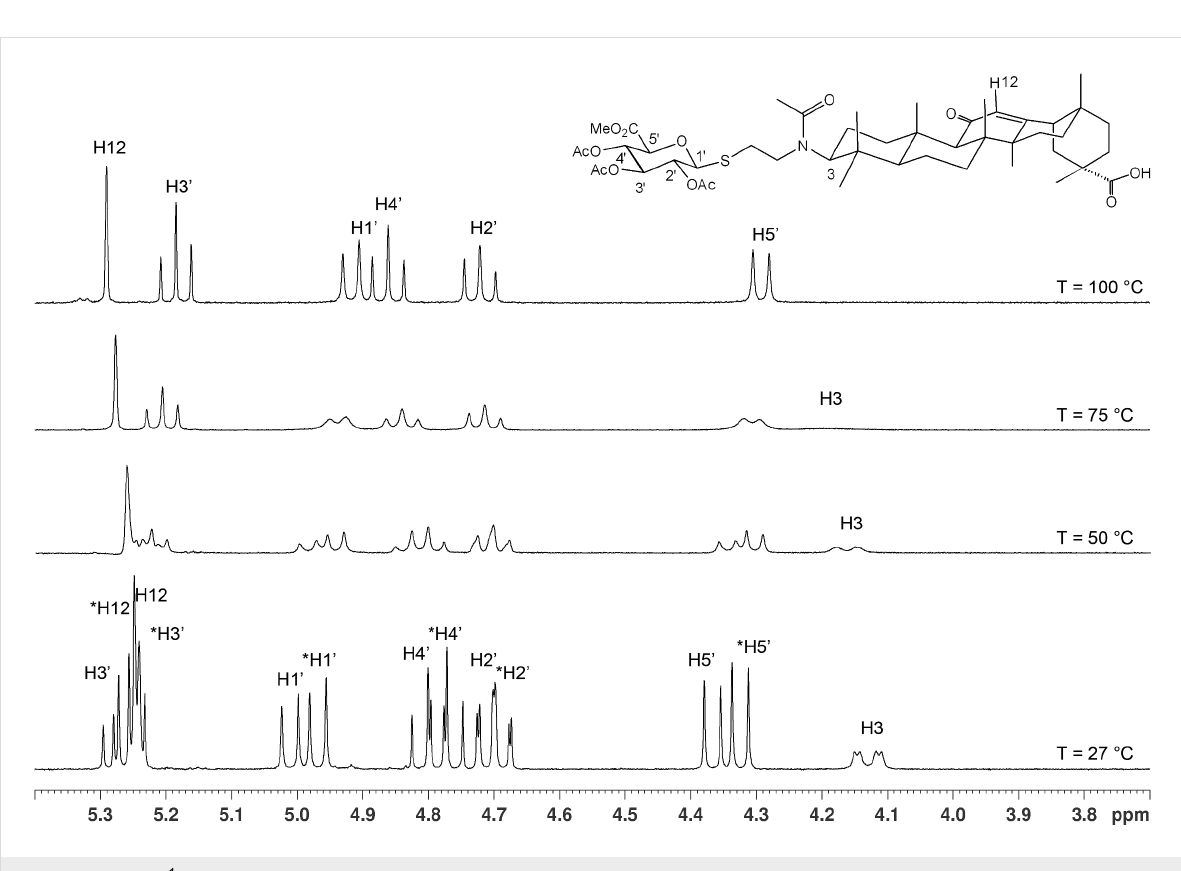
and N -succinyl derivatives, recorded at room temperature, two sets of signals in an approximate 6:4 ratio were observed.